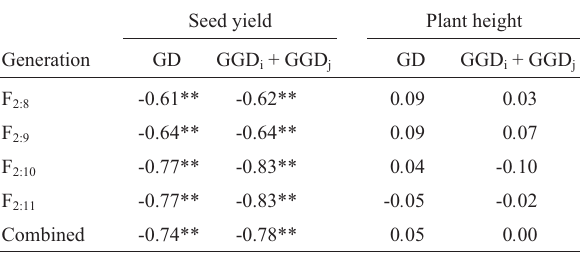
Table 4 - Correlation coefficients between population means (PM) and genetic distances (GD) and the sum of general genetic distances (GGD i + GGD j ) for seed yield and plant height, for F 2:8 to F 2:11 soybean generations and for the combined analysis.